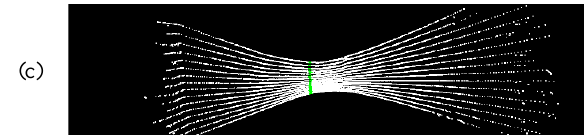
Figure 3. Image Annotation Process: (a) Intensity Filtering, (b) Manual Cleaning, and (c) Labelling.